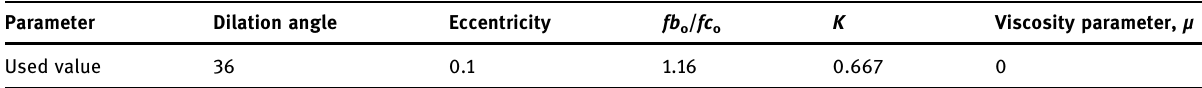
Table 1: Plasticity parameters used in the study [ 15 ]